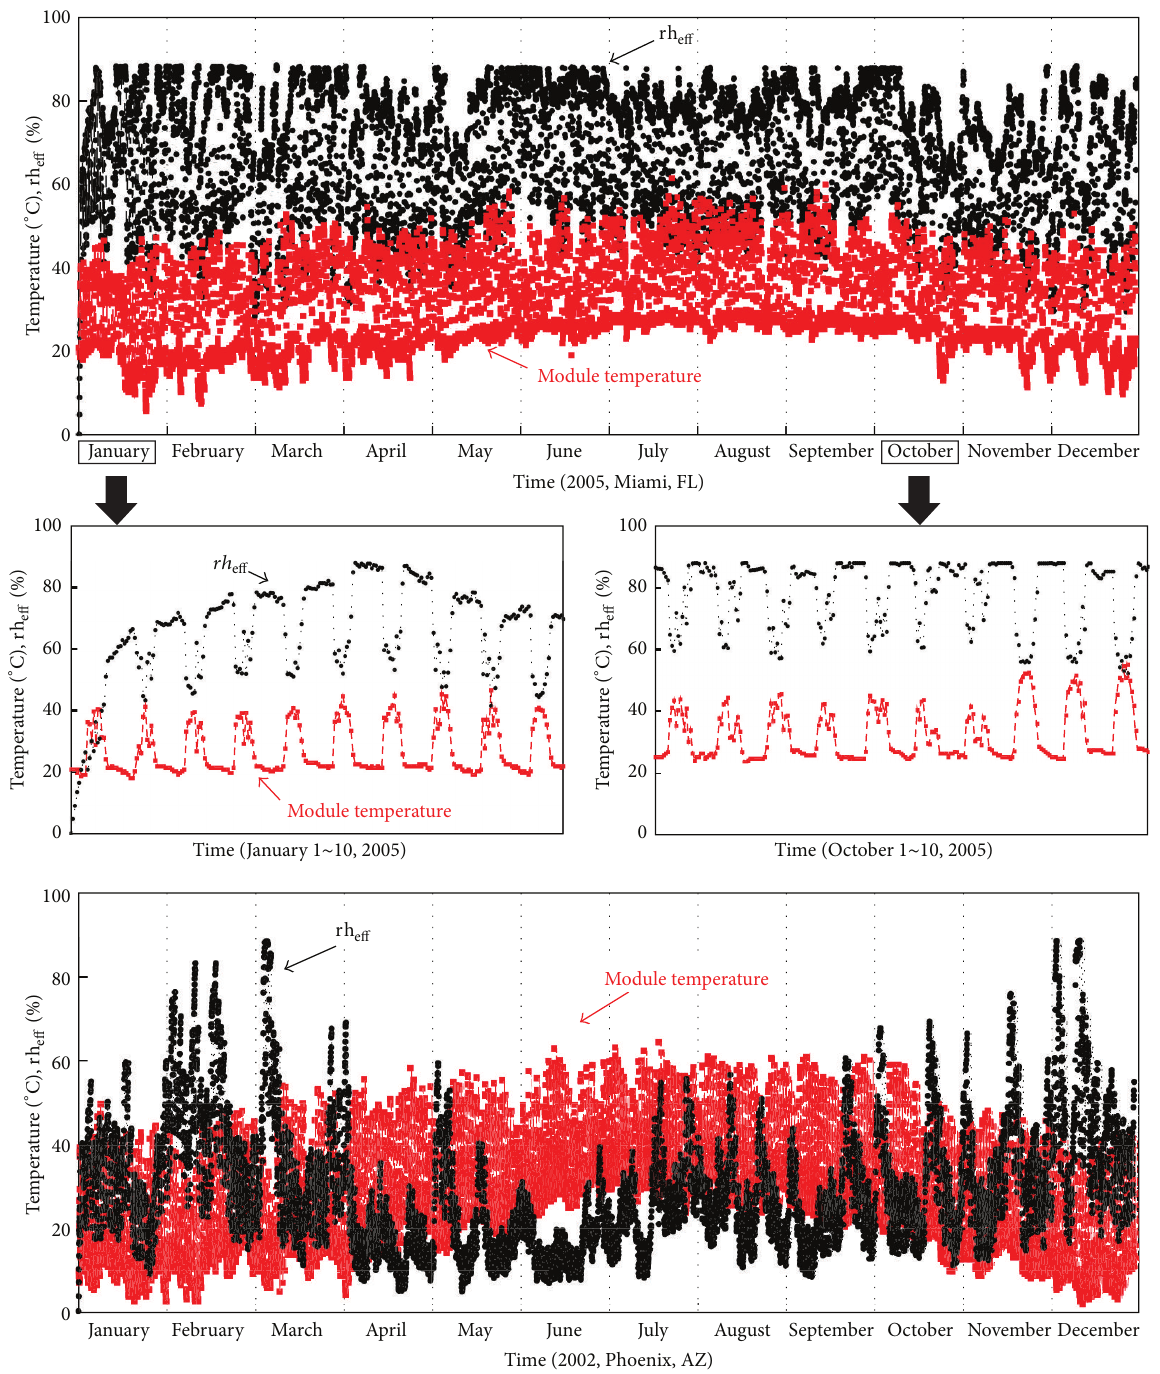
Figure 6: Module temperature and rh eff over one year in 2 benchmark climates. rh eff is determined with (8) for Eyring model. Thermal and rh history of a PV module over one eff , Eyring year were calculated at two BMCs as shown in Figure 6. Compared with Miami, the module temperature at Phoenix is shifted more than 10 ∘ C higher and the rh eff has a relatively low distribution.